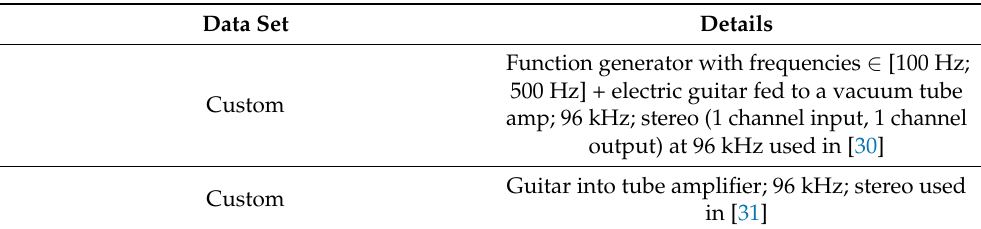
Table 4. Summary of the data sets used for training and their different